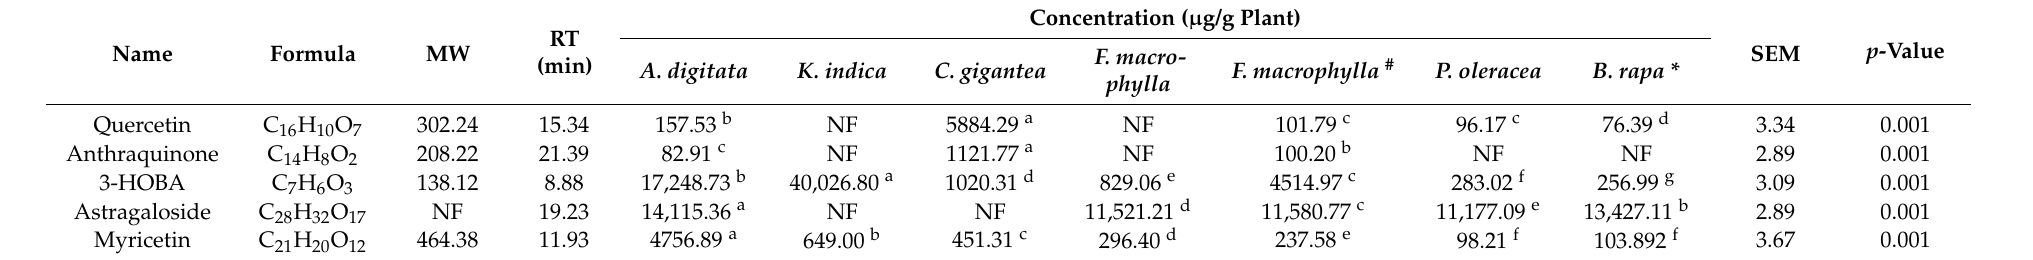
Table 2. Phytochemical compounds found in the extract of the forest